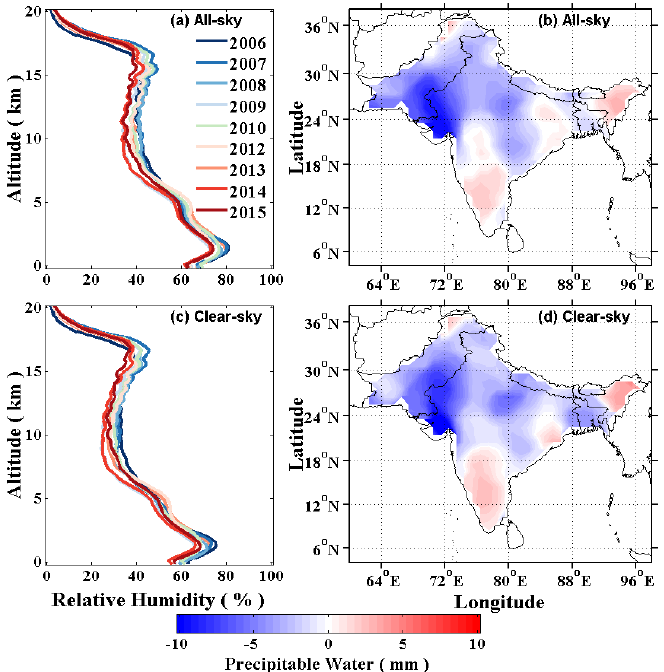
Figure 6. Temporal variations in spatial average vertical RH in ( a ) all-sky and ( c ) clear-sky conditions; spatial distribution of temporal changes in the average PW in ( b ) all-sky and ( d ) clear-sky conditions from the ECMWF-AUX during the monsoon season in South Asia from 2006 to 2015.